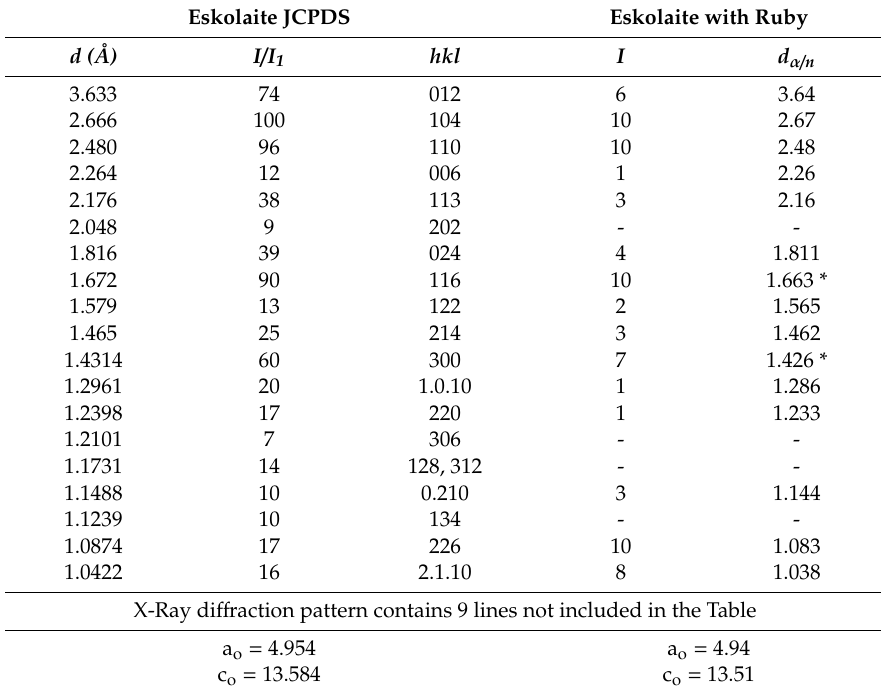
Table 1. Eskolaite X-Ray di ff raction data. Eskolaite JCPDS Eskolaite with Ruby